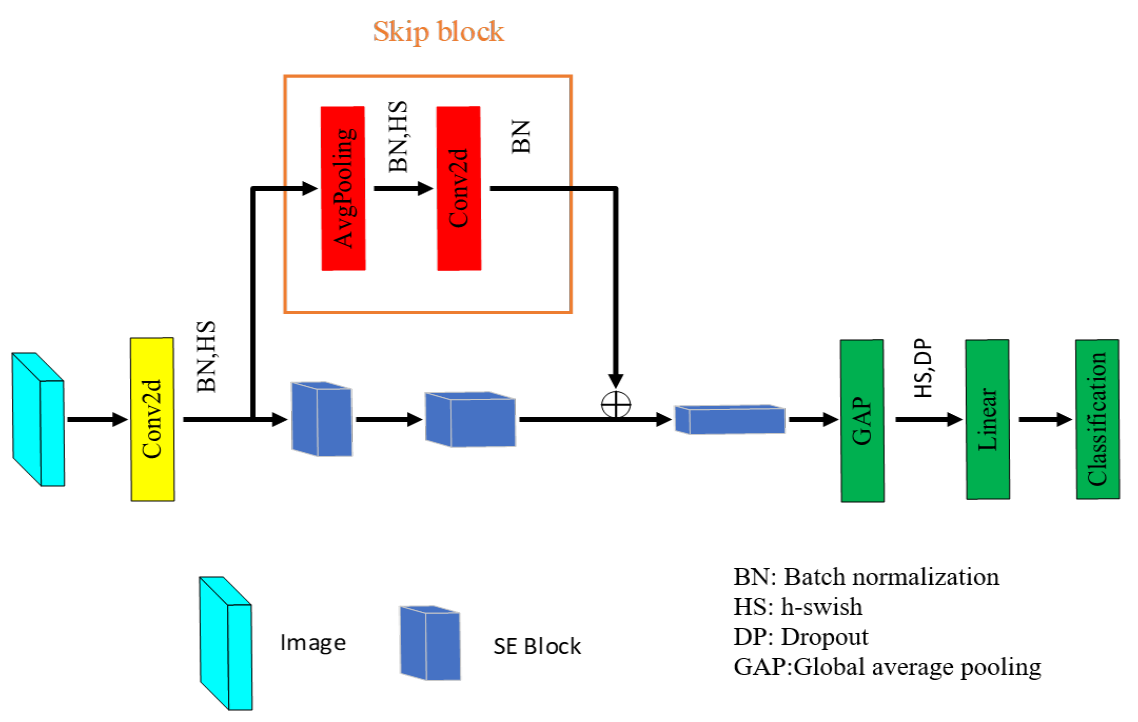
Figure 12. Proposed LDCNN framework in the study.